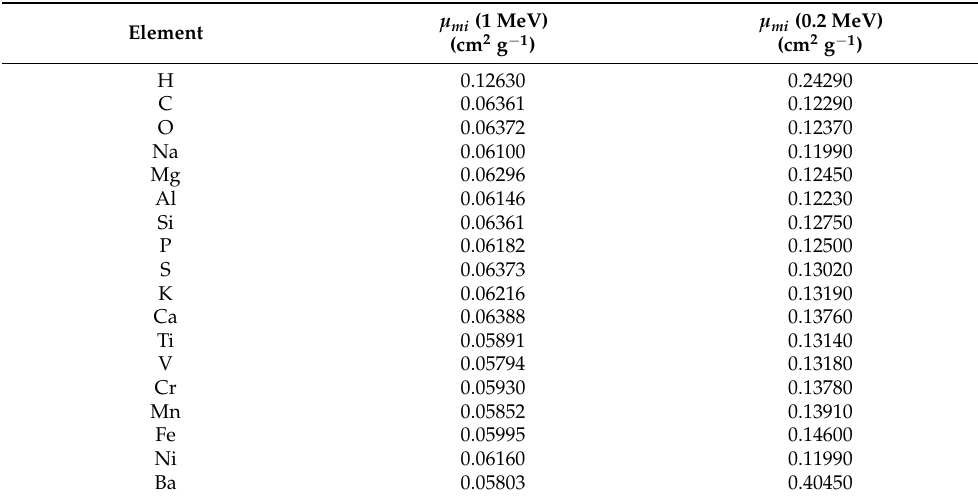
Table 3. The mass attenuation coefficients ( µ ml ) of the elements of the concrete types for 1 and 0.2 MeV X-rays.